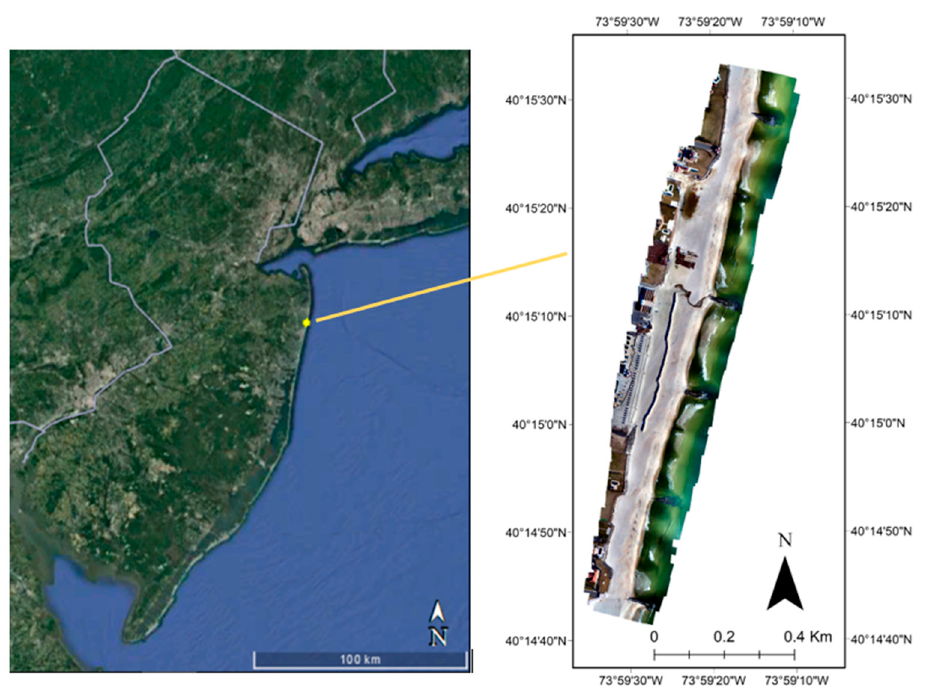
Figure 2. Site Location Map—Deal, New Jersey, USA.